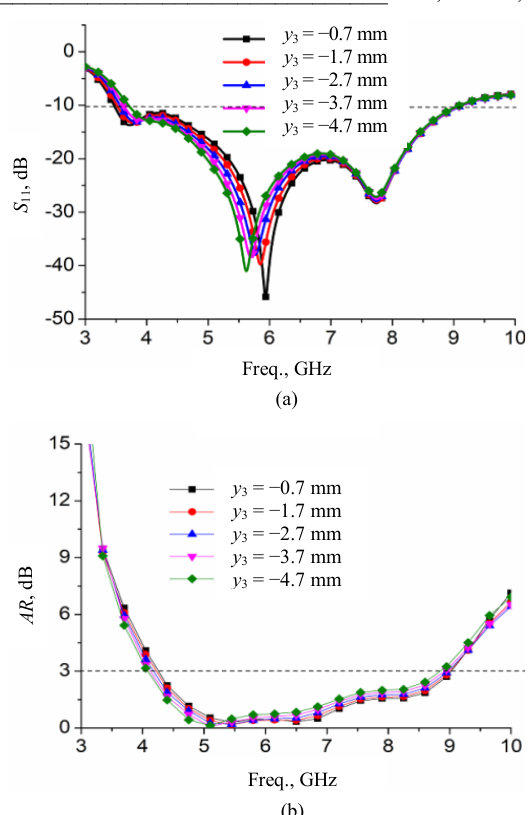
Fig. 11. Effect of ‘ y 3 ’ on impedance bandwidth and axial